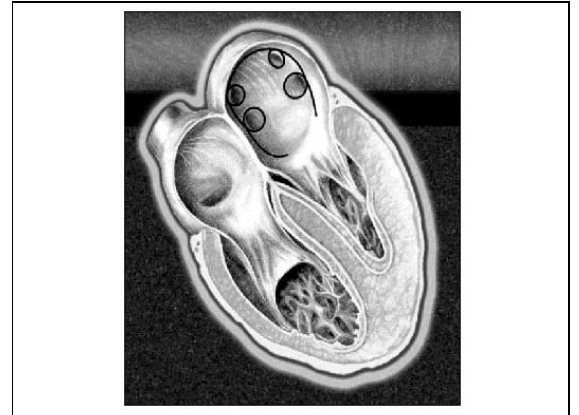
Fig. 4 – Desenho esquemático, mostrando como são realizadas as linhas de ablação no átrio esquerdo, ao redor das veias pulmonares, em forma de U invertido, para tratamento da FAC com ultra-som